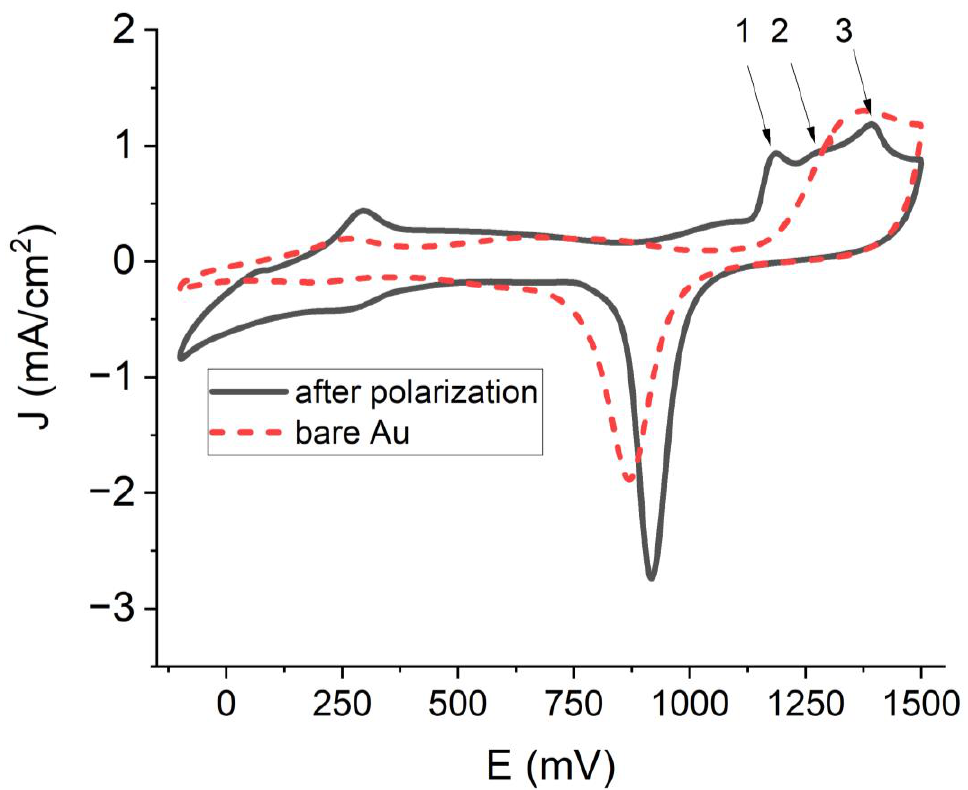
Figure 1. Cyclic voltammograms of the gold electrode in the 1 M H 2 SO 4 solution before and after the electrochemical treatment. The potential was cycled from − 0.1 V to 1.5 V at a potential sweep rate of 0.1 V/s.